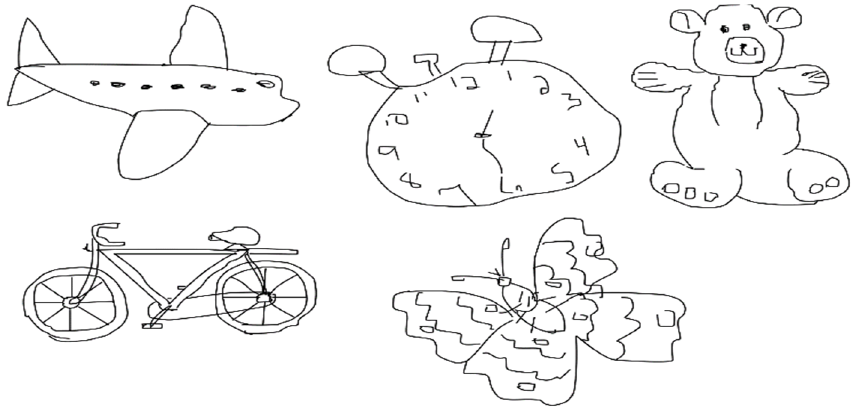
Figure 3. TU Berlin instances